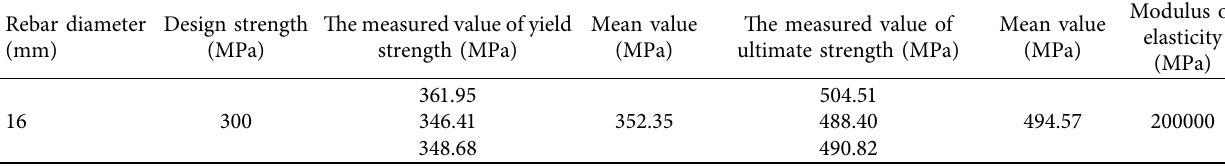
Figure 7: Construction drawing in detail of the RED-HRC (unit: mm). (a) Reinforcement and dimension of RED-HRC. (b) Dimension of RED. Table 1: Performance test results of rebars.